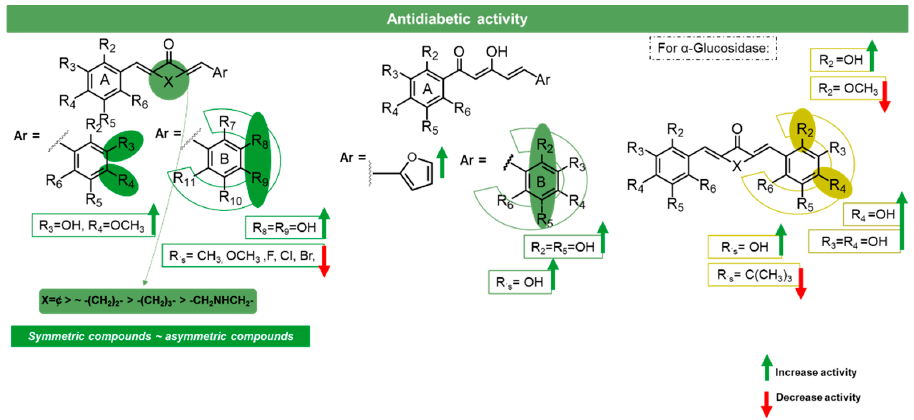
Figure 14. Diarylpentanoids with promising antidiabetic properties.